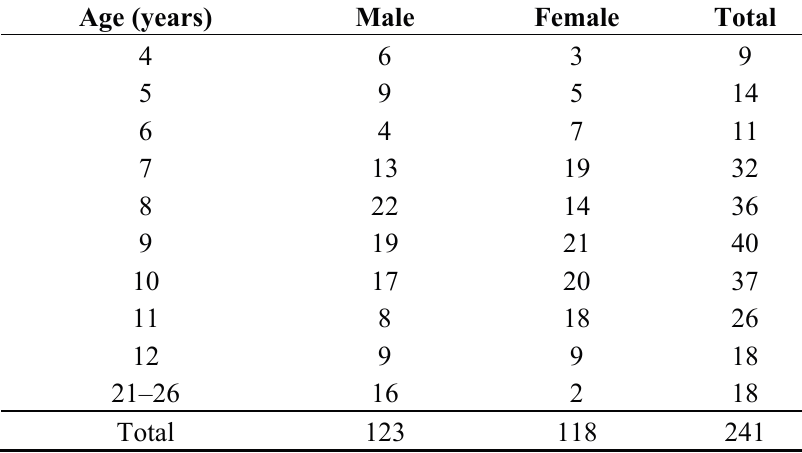
Table 1. Number of study